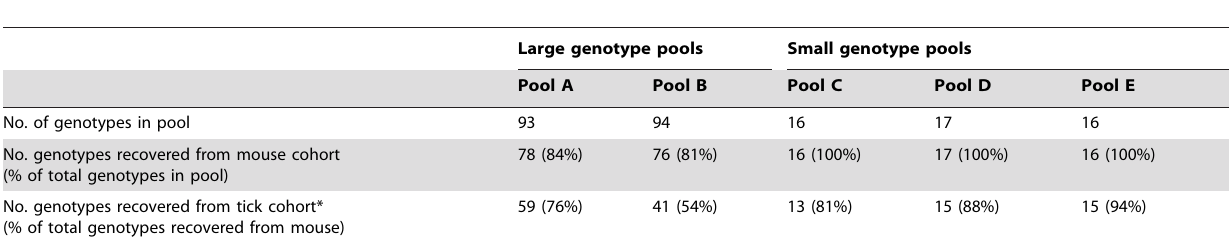
Table 1. Recovery of F. novicida genotypes from populations of mice and ticks exposed to large- or small-pool genotype populations.